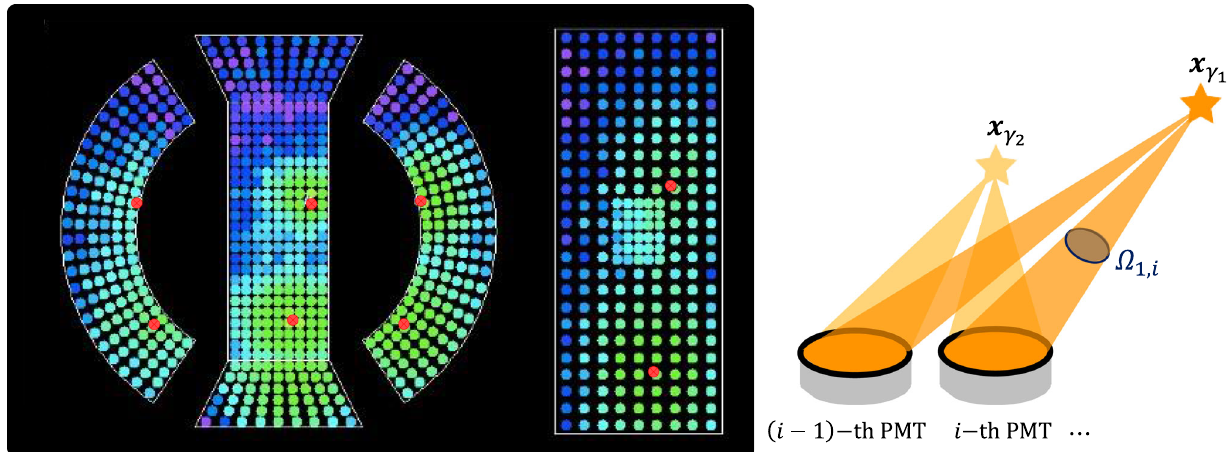
colour indicates the measured light yield, which is the sum of photons from the two showers induced by the two γ s as depicted in the